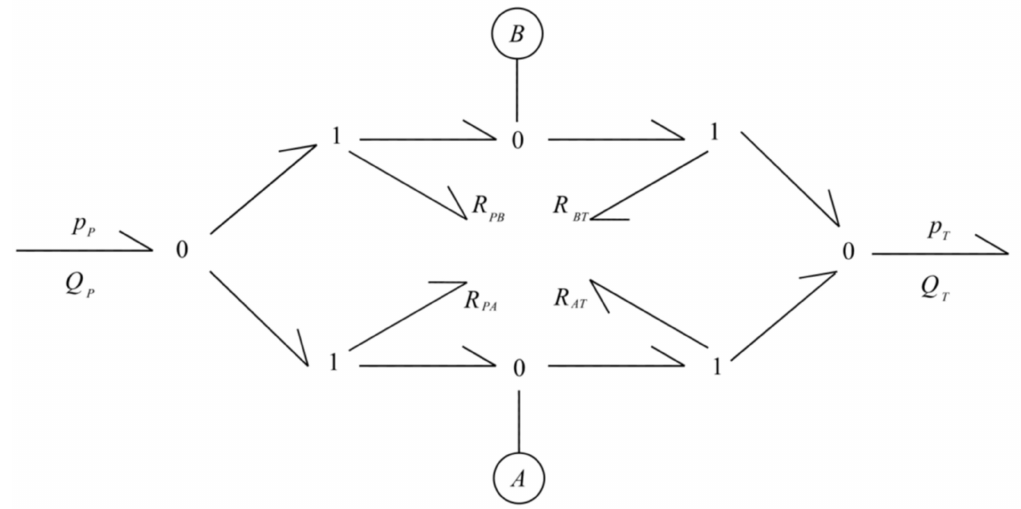
Figure 4. Landing gear selector valve bond